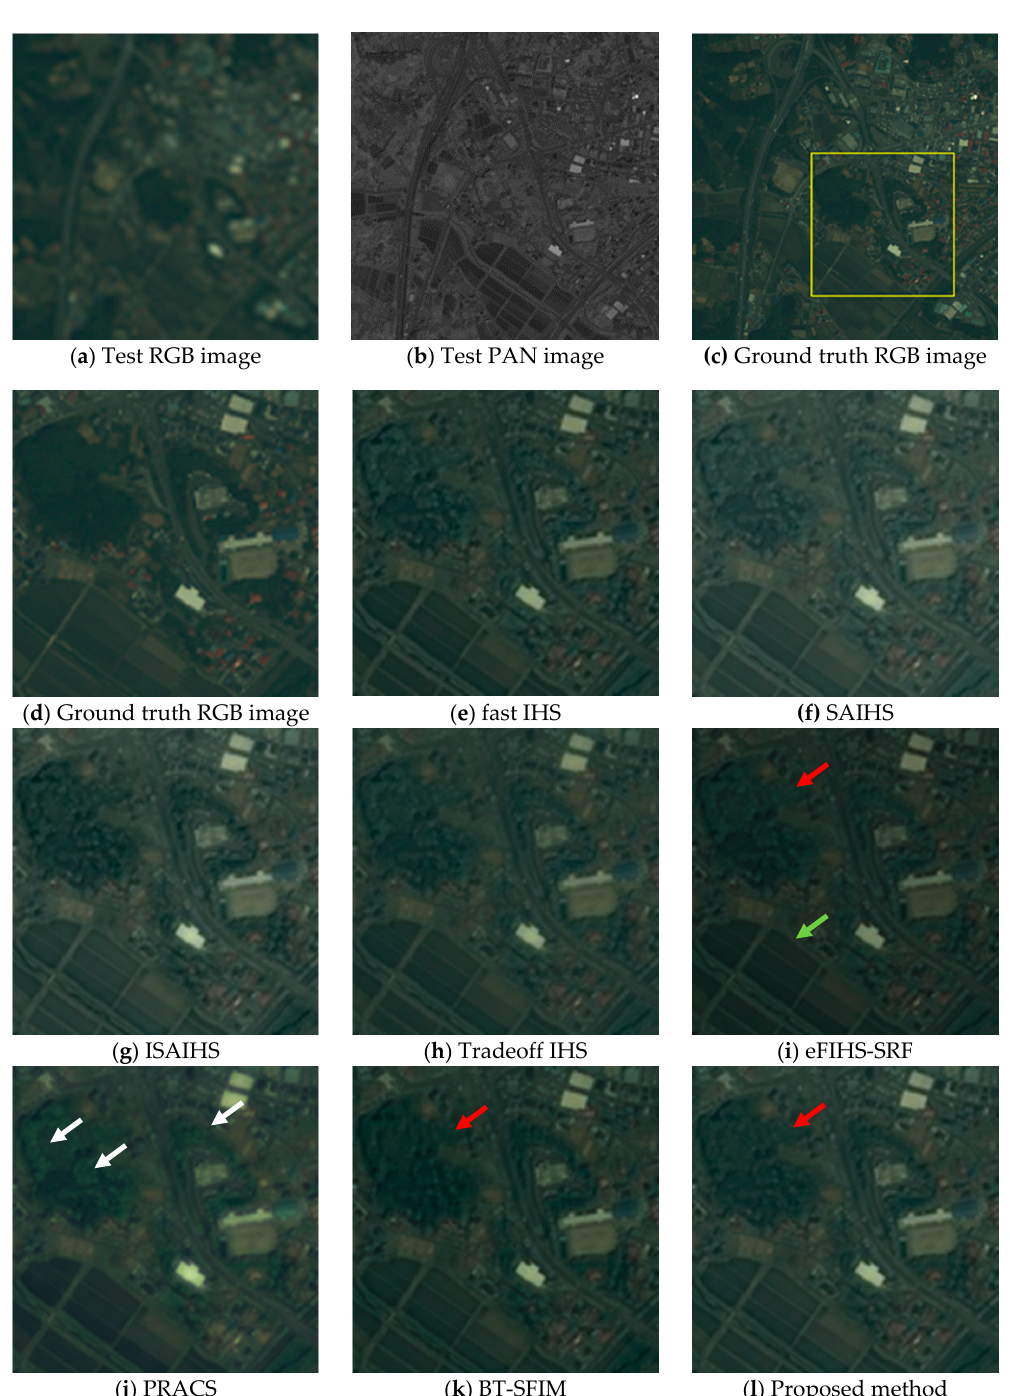
Figure 3. Quality metric result rank in three tested datasets: the score of the quality metrics is expressed as a cumulative bar chart.